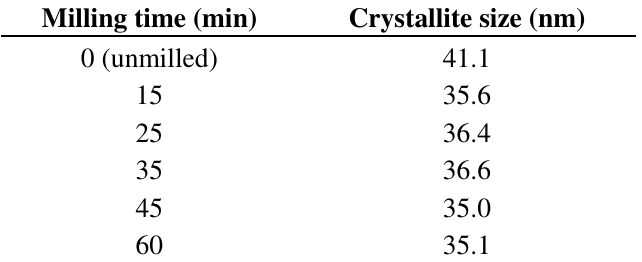
Table 1. Crystallite